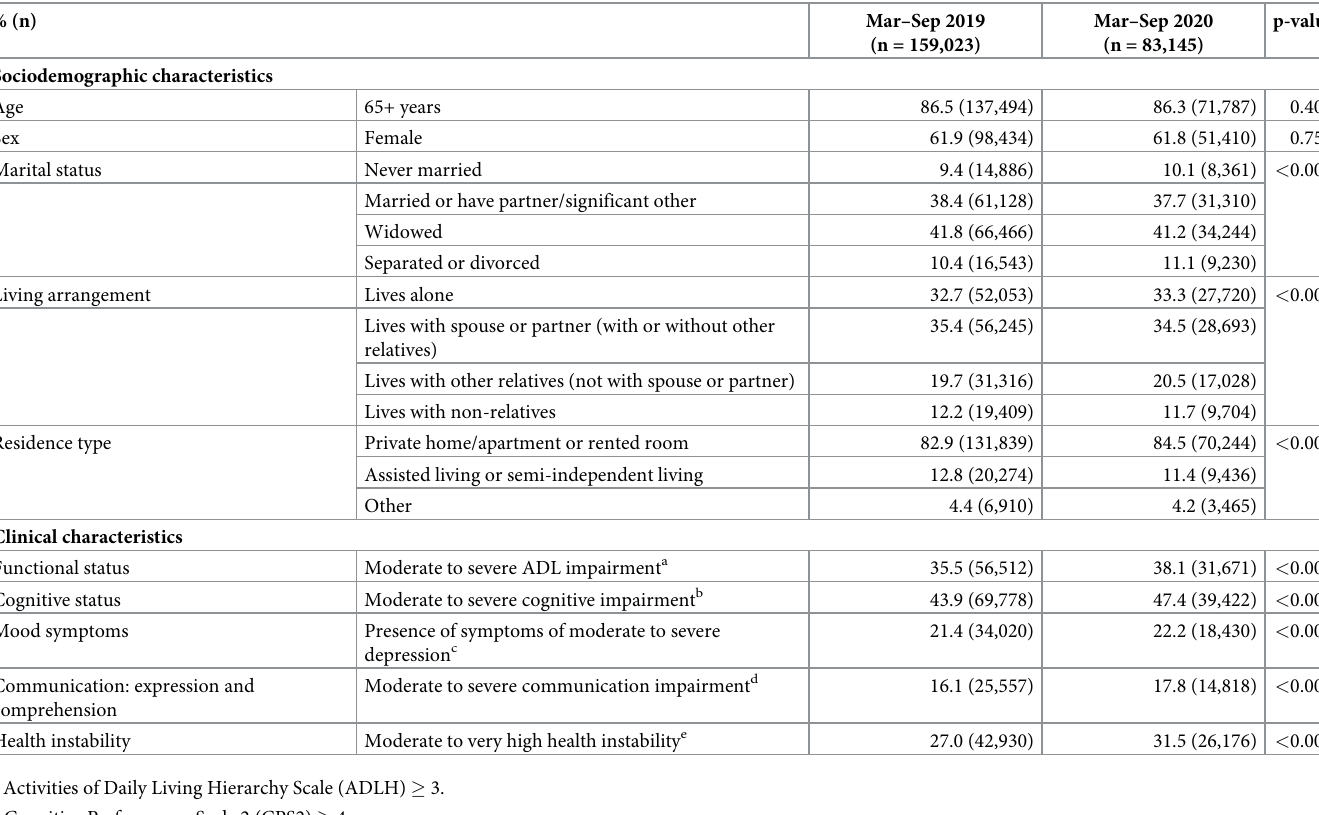
Table 1. Comparison of sociodemographic and clinical characteristics of home care patients receiving a comprehensive assessment from March to September, in 2019 and